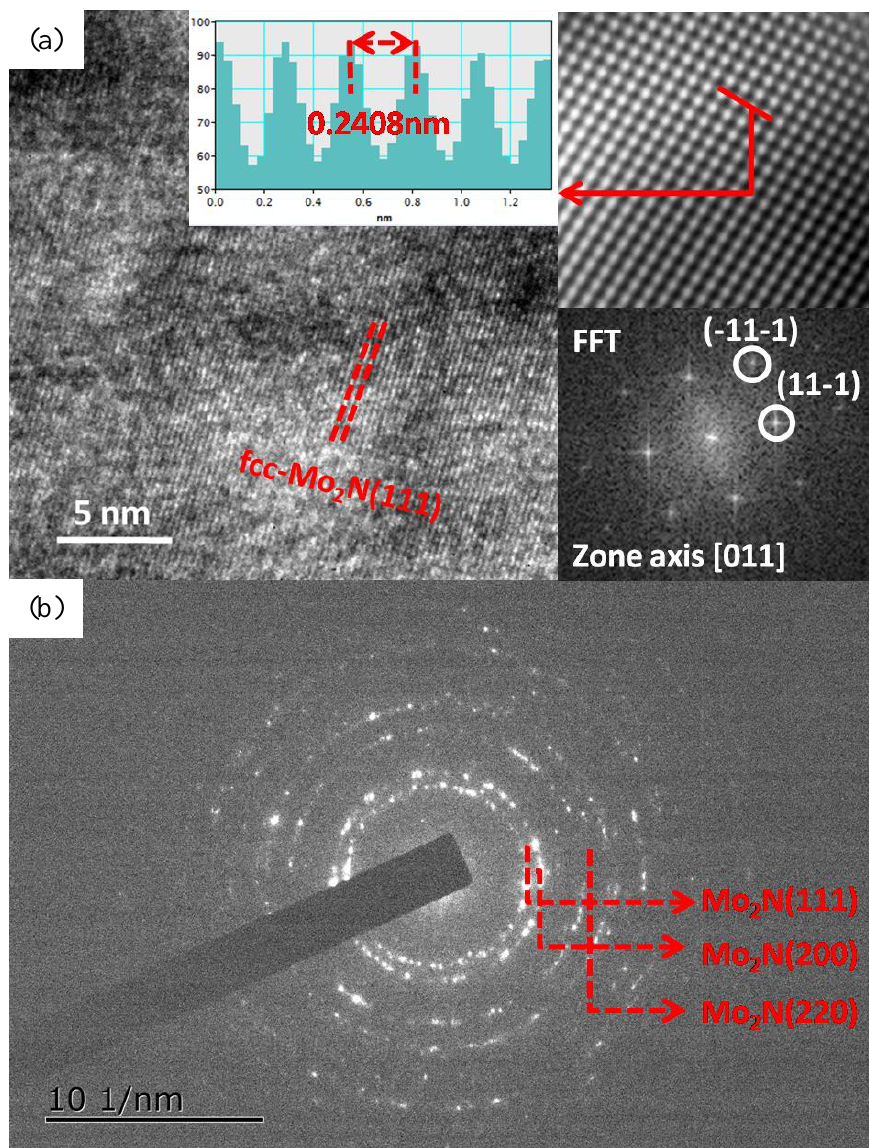
Figure 3. Image ( a ) and the corresponding SEAD pattern ( b ) of the Mo 2 N film.